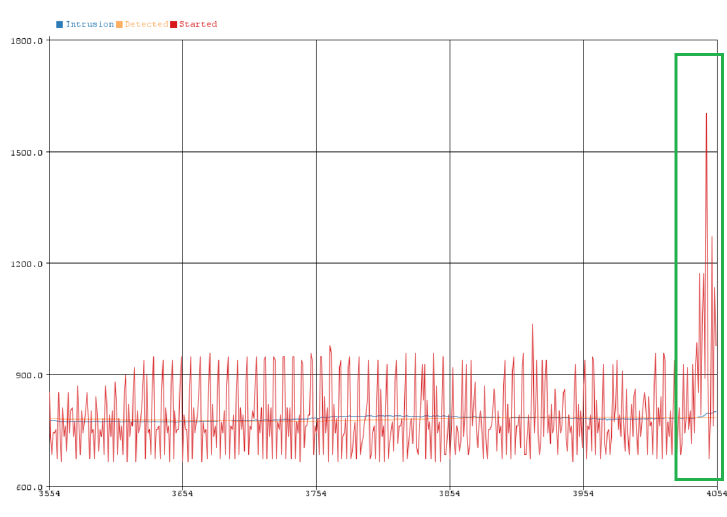
Figure 14. Intrusion Detected 1.